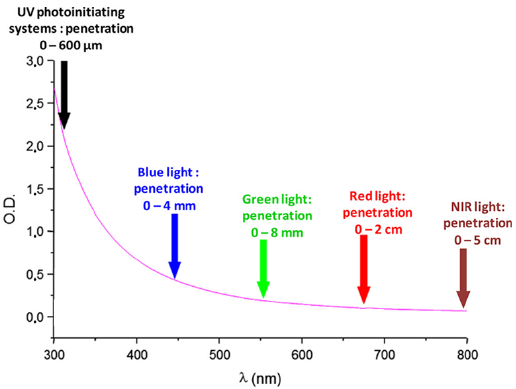
Figure 1. Light penetration in a polystyrene latex with an average particle diameter of 112 nm. Reprinted with permission from Bonardi et al. [31].